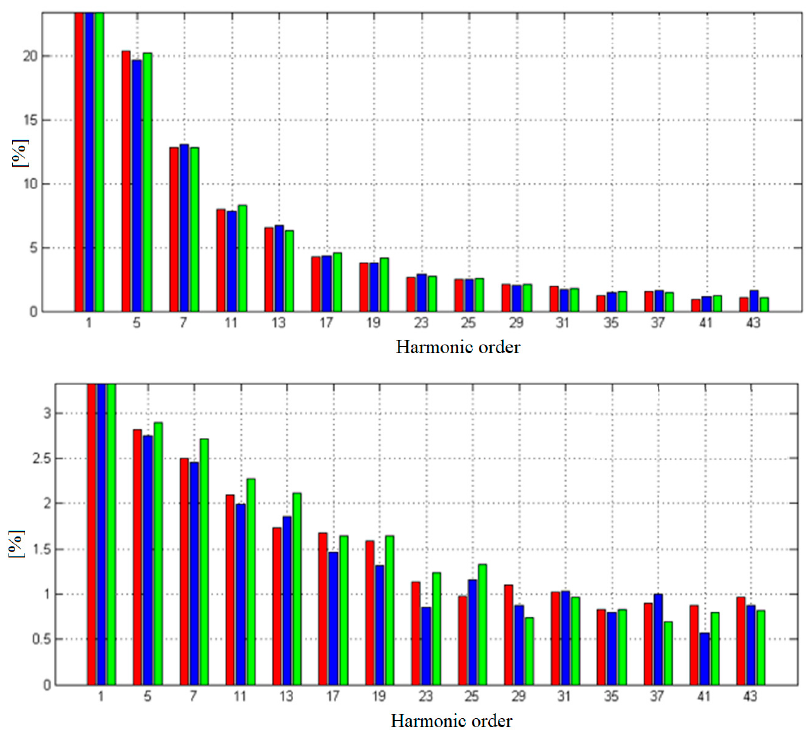
Figure 4. Harmonic spectra of the absorbed currents ( top ) and input voltages ( bottom ) were acquired from the secondary winding of the transformer for the excitation supply (harmonic weights > 1.2%). The (re)active powers were computed by using the harmonic spectra and Equations (9), (12) and (21). Their spectra are depicted in Figure